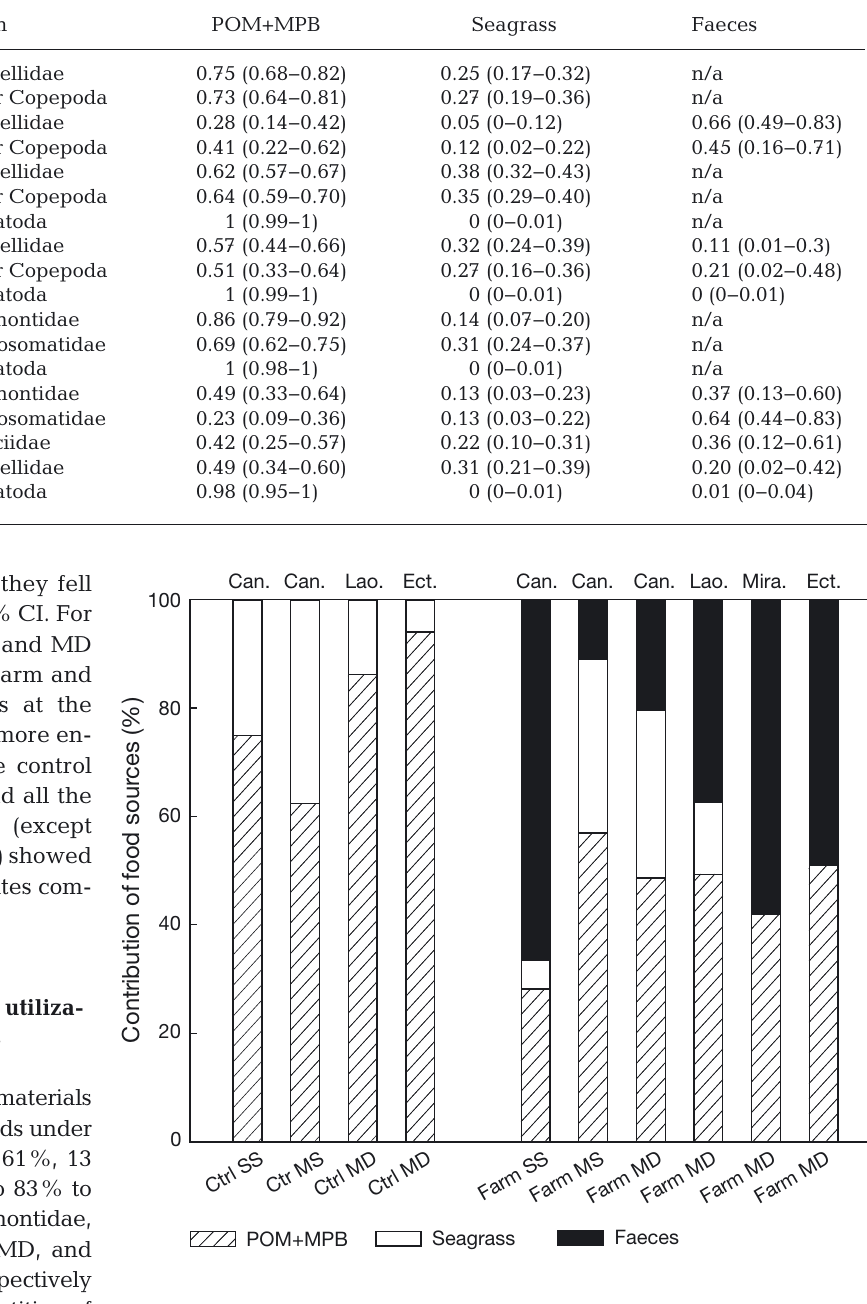
Fig. 4. Proportion of mean contributions of food sources to different families of harpacticoid copepods collected from ‘farm’ and ‘control’ sites at 3 stations (SS, MS and MD) at scallop farms in Laizhou Bay, China in 2016. See Fig. 1 legend for abbreviations of stations. Food sources analysed were scallop fae- ces, seagrass Zostera marina, and particulate organic matter plus microphyto- benthos (POM+MPB). Can.: Canuellidae, Lao.: Laophontidae, Mira.: Mira- ciidae, Ect.: